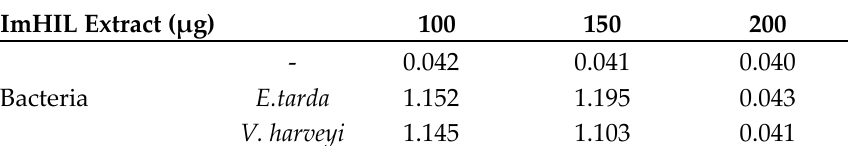
Figure 1. Analysis of cecropin 1 and defensin transcript ( A ), radial diffusion assay ( B ), and minimum inhibitory concentration ( C ) using ImHIL inoculated with Lactobacillus plantarum . ImHIL, immunized HIL. * p <0.05 and ** p <0.01 represent significant differences between 0 h and 2, 4, 8, 16, 24, 48, and 72 h postinjection, respectively.